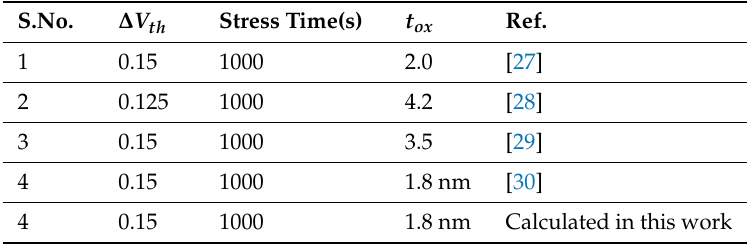
Table 3. Comparison of the modeling results with the experiment